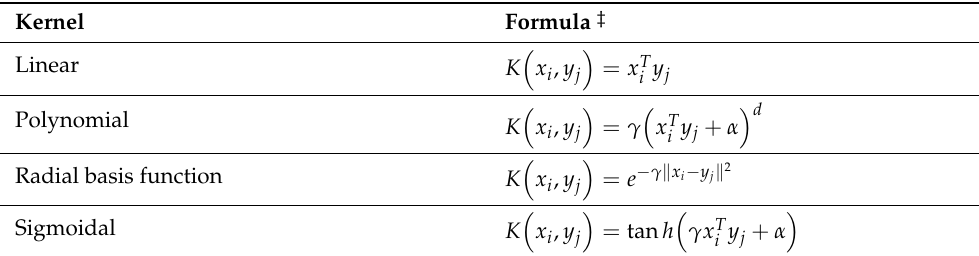
Table 2. Kernels used in support vector machine (SVM) model. Meta-parameters used for tuning include gamma ( γ ), degree of polynomial ( d ) and intercept ( α